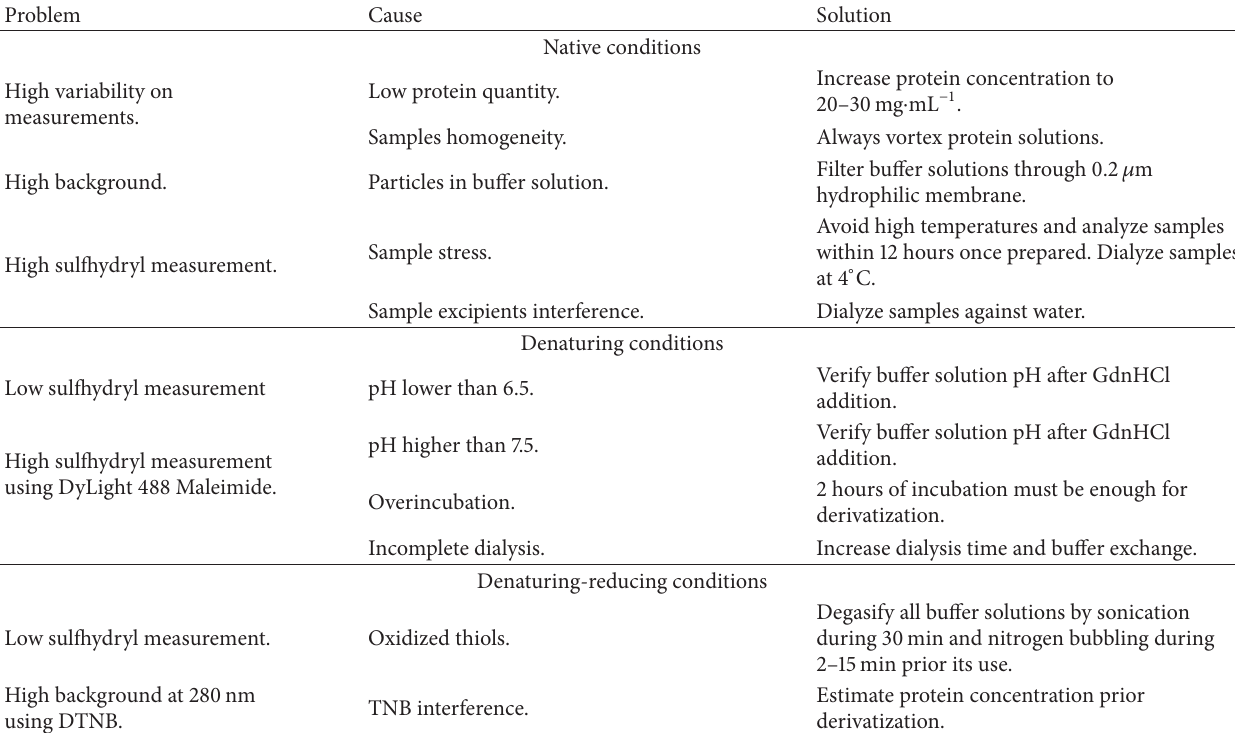
Table 8: Troubleshooting for DTNB and DyLight 488 Maleimide